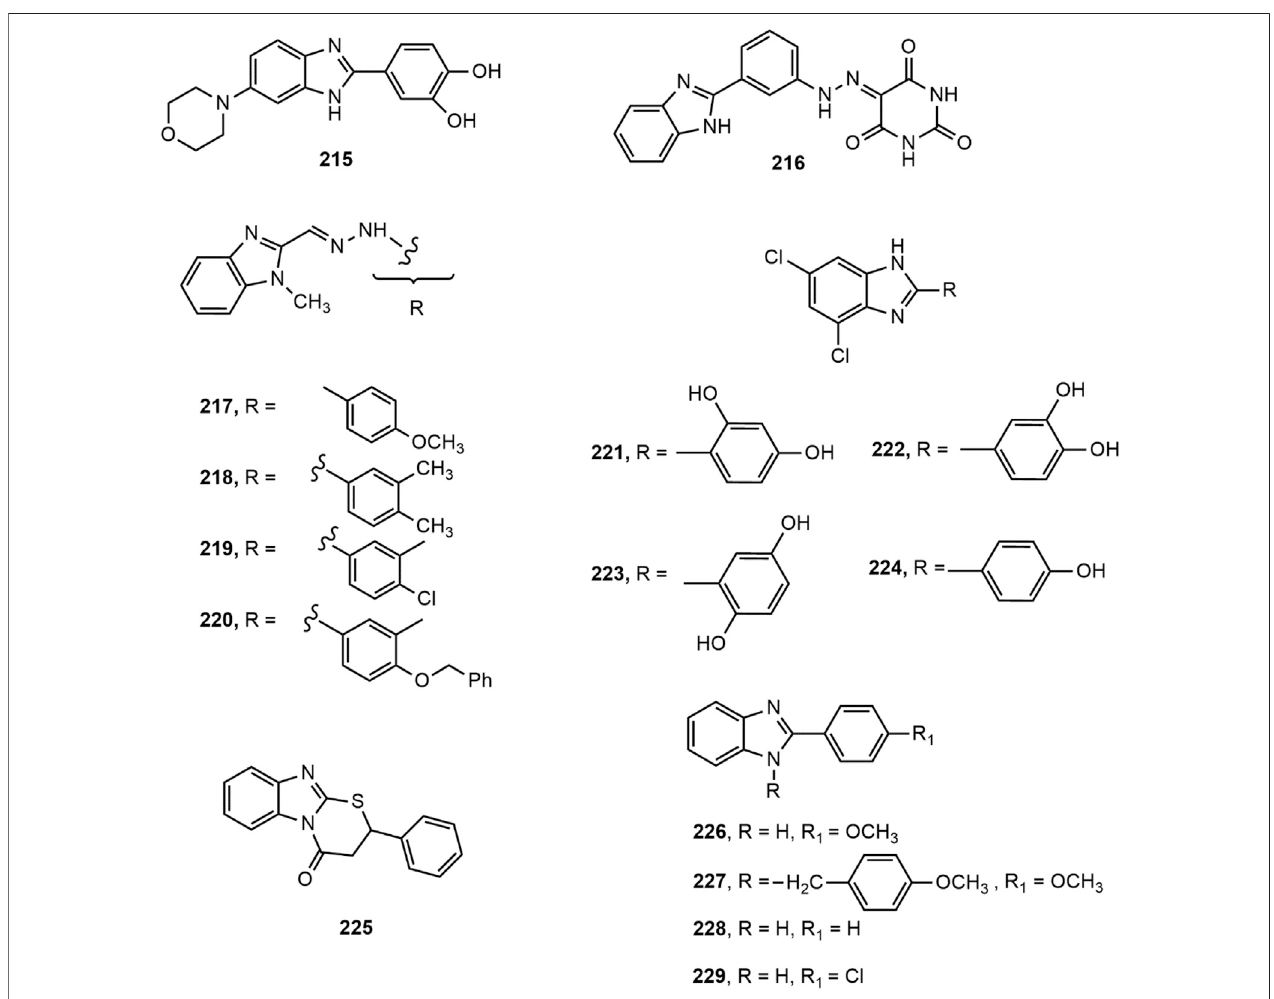
FIGURE 8 | Benzimidazole derivatives with antioxidant